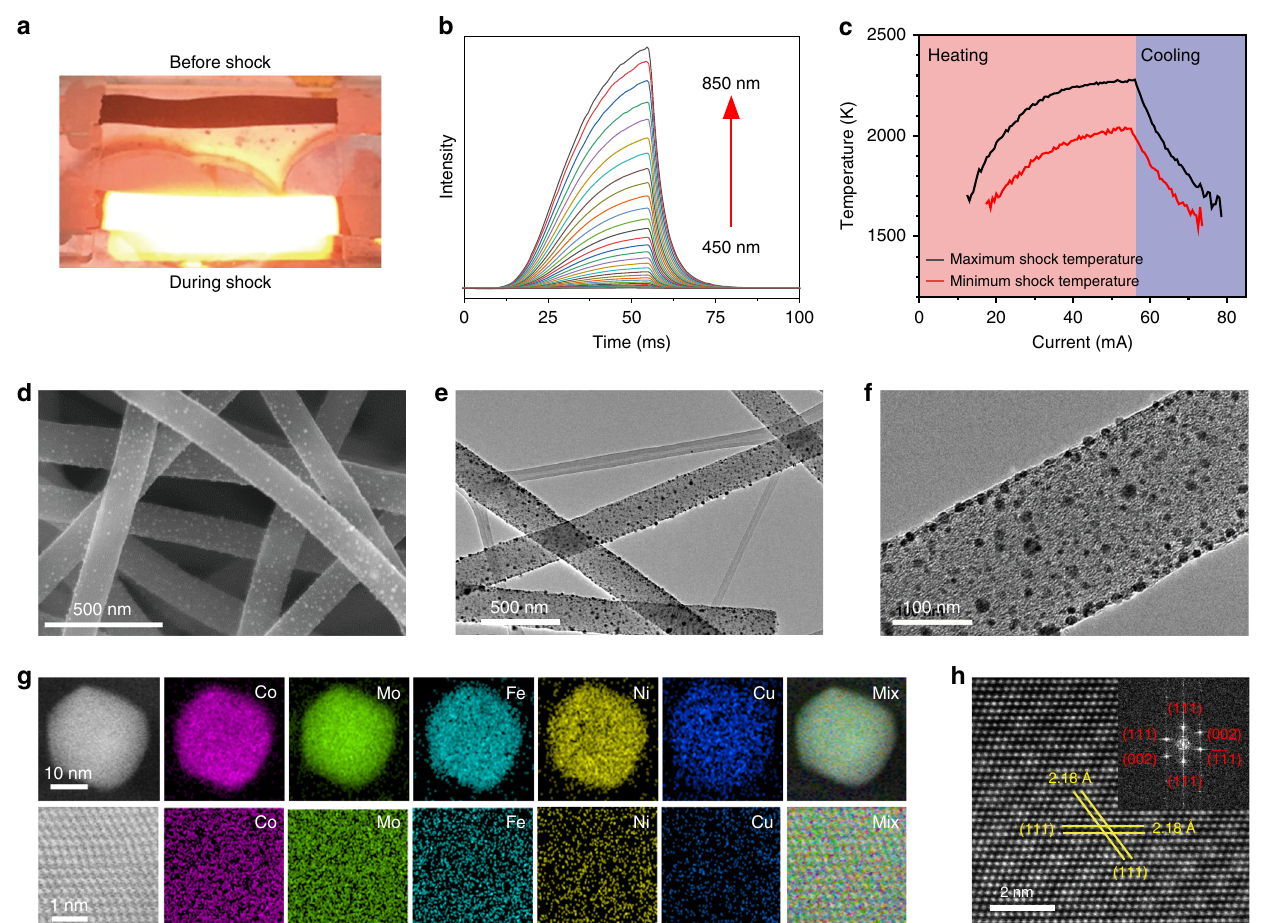
Fig. 2 High-entropy alloy CoMoFeCoNi (HEA-Co x Mo y ) nanoparticles. a Digital images of the samples before and during the thermal shock synthesis. b Intensity of the emitted light from the shock at different wavelengths. c Typical temperature pro fi les during the thermal shocks as determined from the emission intensities. d Representative SEM and e , f TEM images of the obtained HEA nanoparticles well dispersed on carbon nano fi bers (CNFs). g STEM- based elemental maps of the HEA-Co 25 Mo 45 nanoparticles at low- (upper panel) and high- (lower panel) resolutions. h High-resolution HAADF-STEM image with the fast Fourier transform (FFT) pattern indicating an fcc crystal throughout the C 25 Mo 45 Fe 10 Ni 10 Cu 10 nanoparticles (Fig. 2g and Supplementary Fig. 3), and similar observations were also obtained on the HEA nanoparticles of different compositions (Supplementary Figs. 4 – 7). In contrast, the bimetallic Co 36 Mo 64